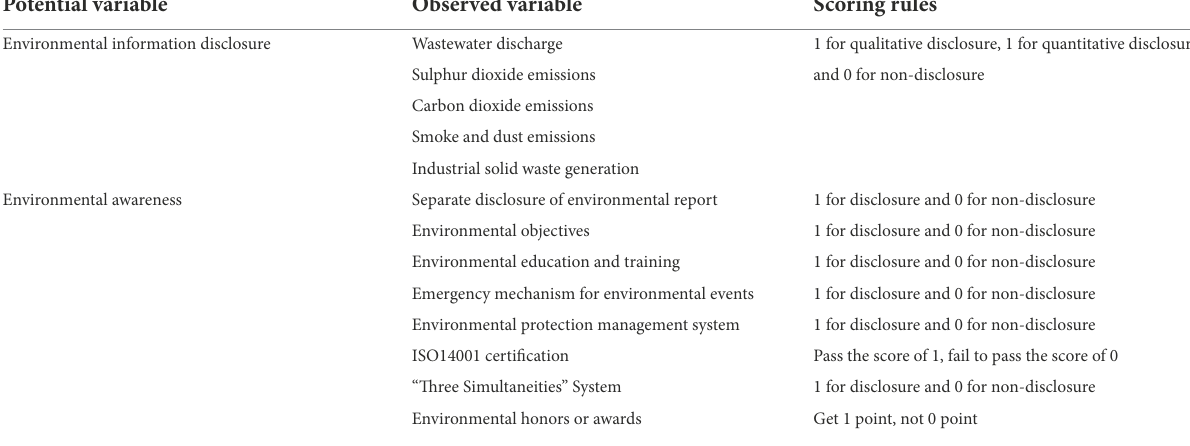
TABLE 1 Summary of potential and observed variables. Potential